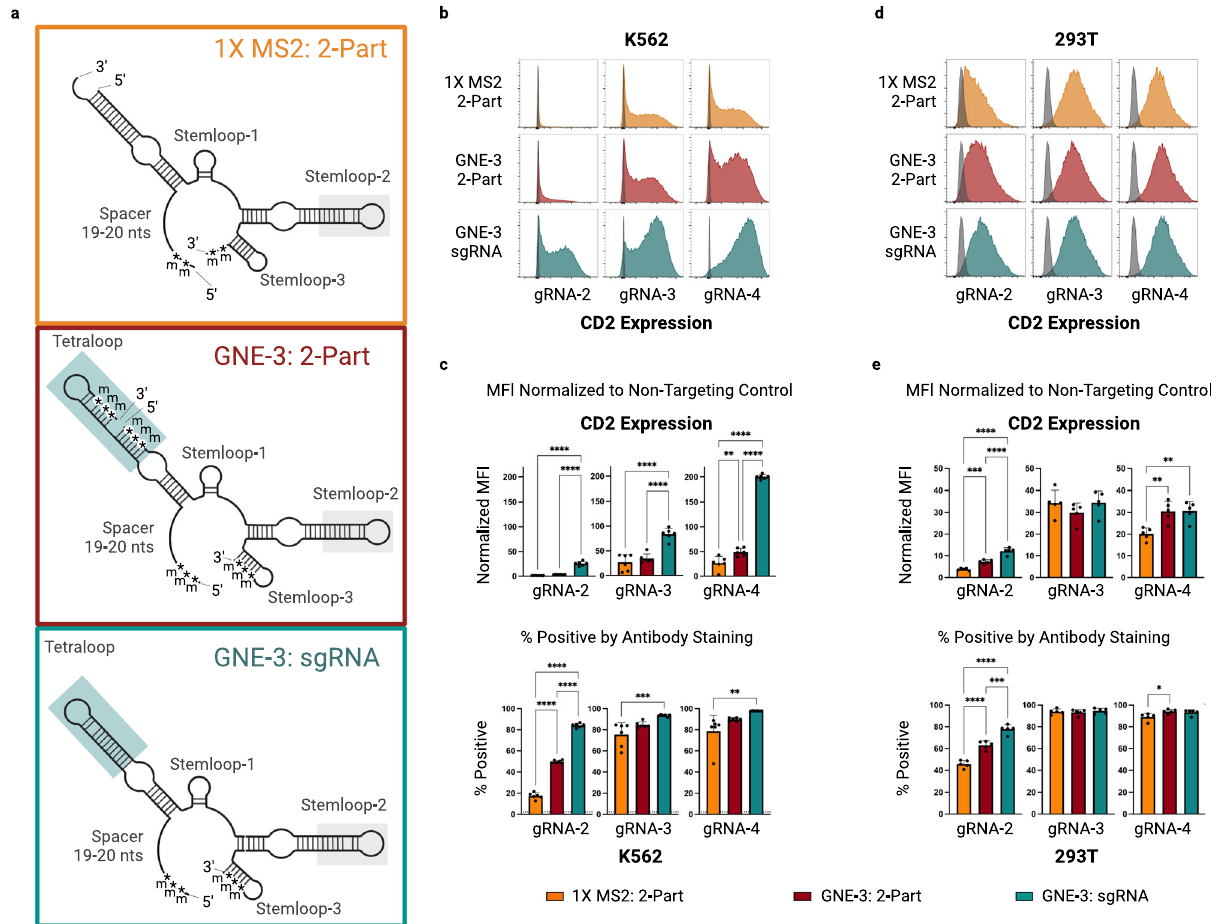
Fig. 5 | Evaluation of CRISPRa synthetic guide formats across 2 cell lines. a Structure diagrams of a commercially available, chemically modi fi ed, 2-part synthetic gRNA containing a single MS2 aptamer loop (top-orange); a modi fi ed, 2-part Format 1 synthetic gRNA containing a GNE-3 scaffold (center-maroon); or a modi fi ed sgRNA with a GNE-3 scaffold (bottom-teal). Blue shaded boxes highlight the MS2 aptamer-containing GNE-3 tetraloop and gray shaded boxes indicate the MS2-apatmer on stemloop 2. b – e CRISPR-mediated transcriptional activation of a CD2 target gene in two CAG-CRISPRa-sel-engineered cell lines (K562 or 293T) by electroporated modi fi ed, synthetic gRNAs in the formats depicted in a . CD2 target activation by 3 spacer sequences in an engineered K562 cell line assessed by fl ow cytometry. CD2 expression displayed by representative histograms overlaid with a